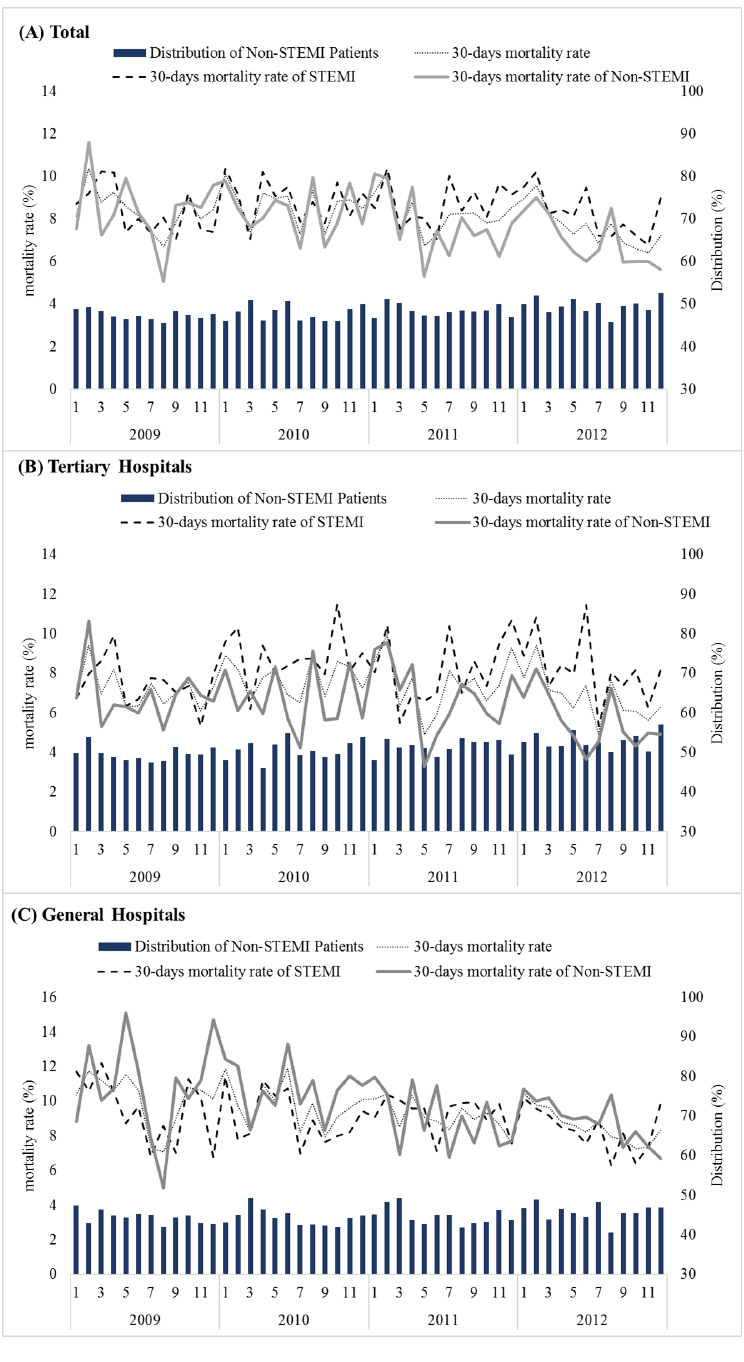
Figure 2. 30-day mortality rate and distribution of NSTEMI patients (2009 to 2012). ( A ) Total; ( B ) Tertiary Hospitals; ( C ) General Hospitals.